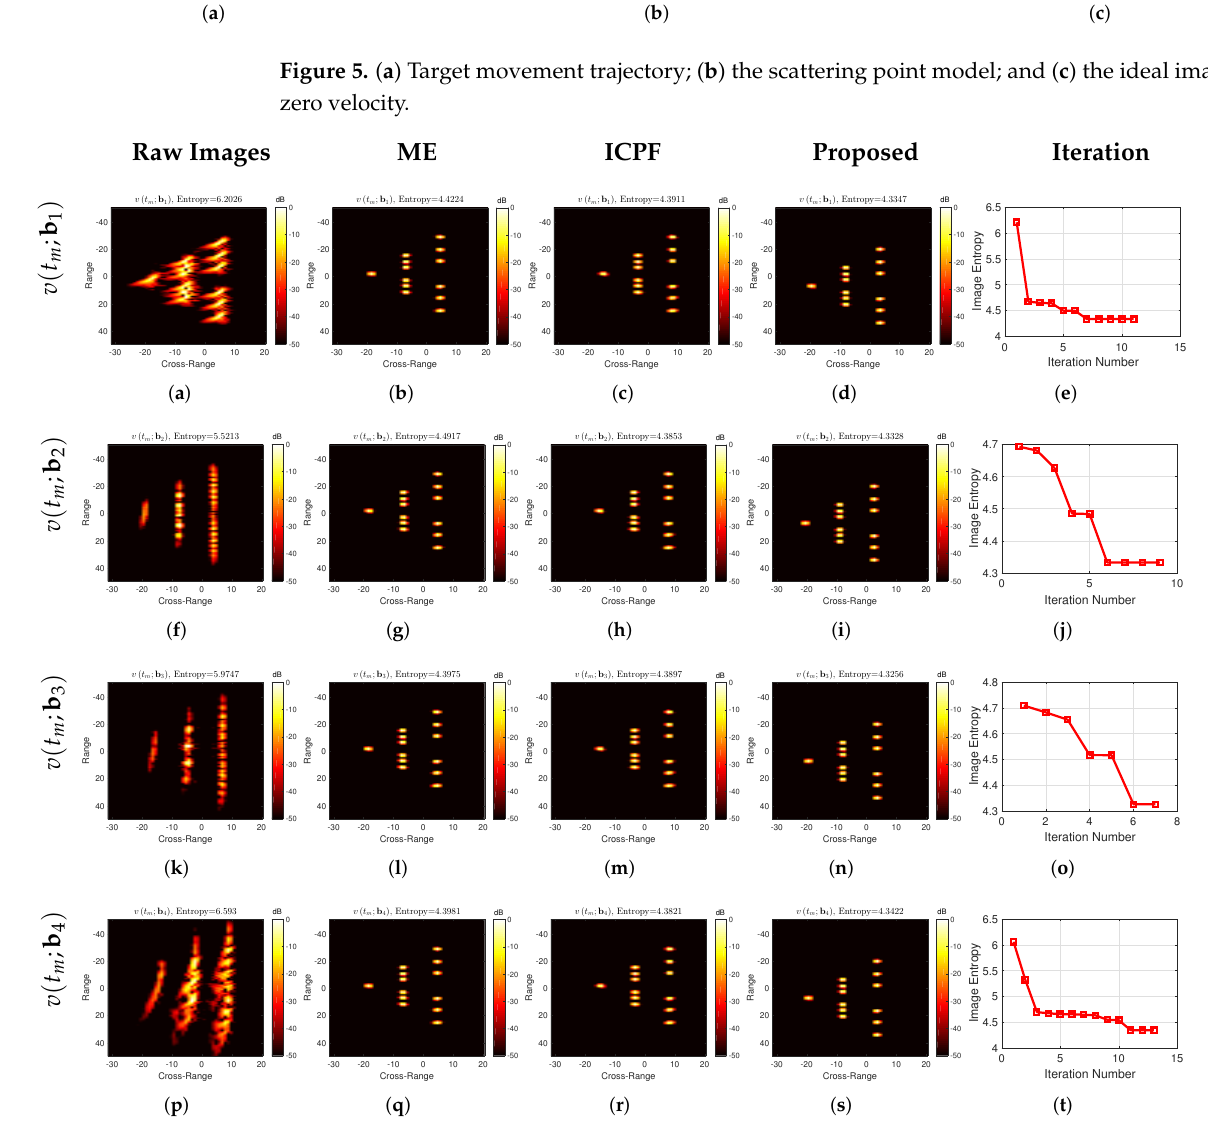
Figure 6. High-speed compensated imaging results under different motion conditions. The leftmost column is the imaging results without high-speed motion compensation; the second column is the high-speed compensation imaging results by ME; the third column is the high-speed compensation imaging results by ICPF; the fourth column is the high-speed compensation imaging results of the proposed algorithm; the rightmost column is the image entropy against the iteration number of the proposed